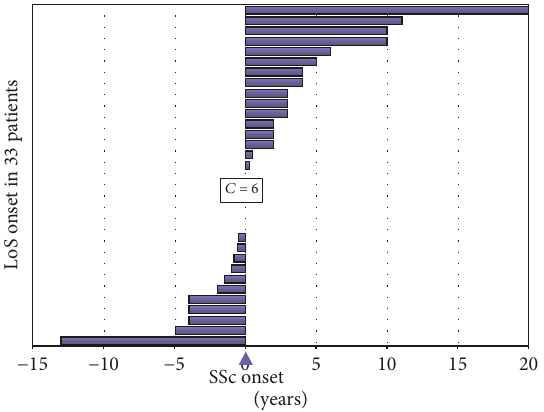
Figure 1: Graphical representation of the LoS onset in 33 patients (25 cases from the literature plus our 8 cases) concerning SSc onset (coloured bars correspond to the time spans between LoS and SSc beginnings). LoS may appear before or after SSc diagnosis, mainly in a time period between − 5 and +5 years from SSc onset (27/33, 81.8%). To note, in 5 patients LoS and SSc presented contemporarily (“ 𝐶 = 6